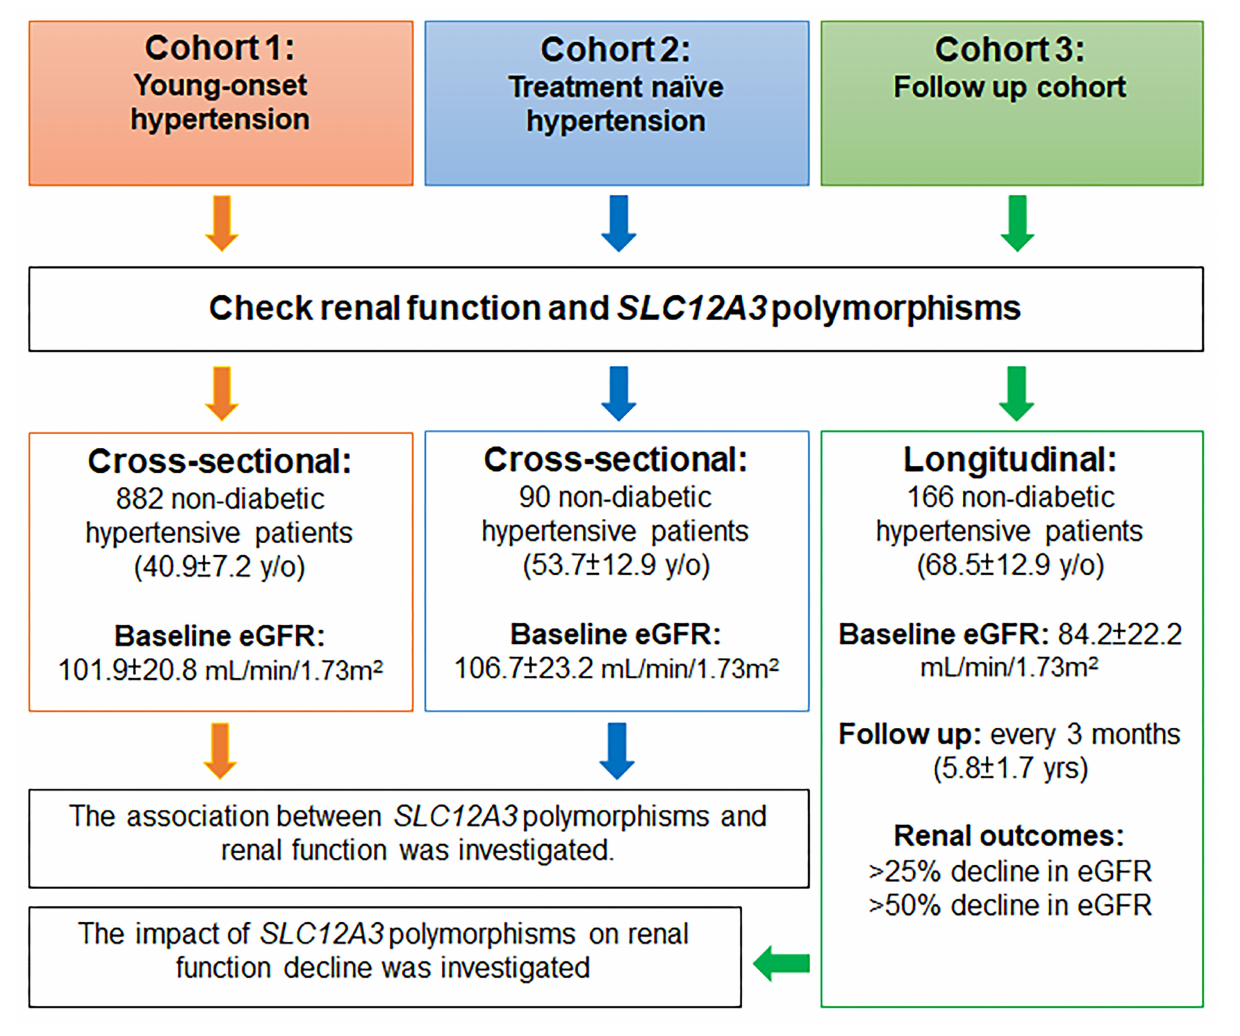
FIGURE 1 | Flow chart of the